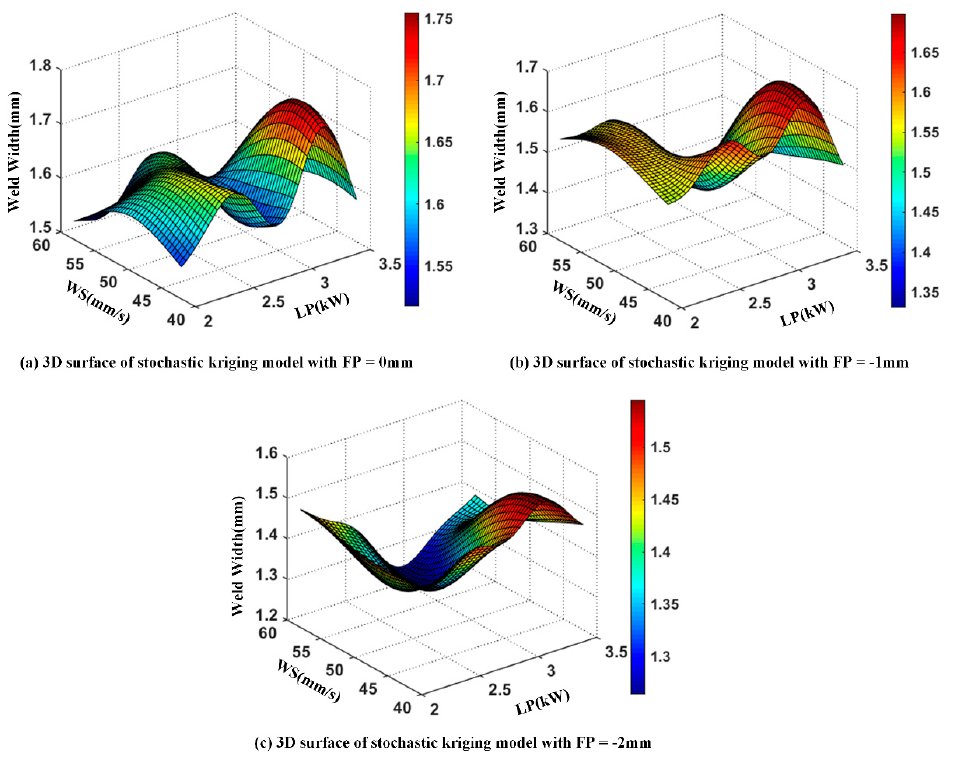
Figure 6. The stochastic kriging model for weld width prediction.